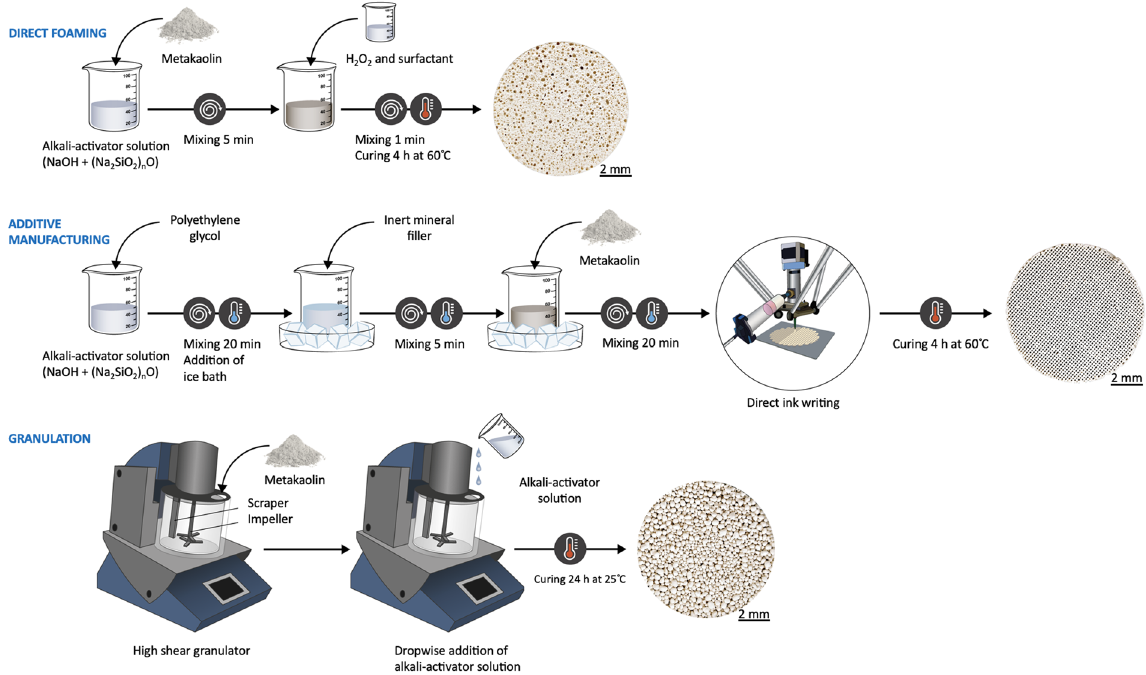
Figure 1. Manufacturing methods and appearance of geopolymer samples. Note that in direct foaming, the solid surfactants were dissolved to alkali-activator solution (i.e., not added together with H 2 O 2